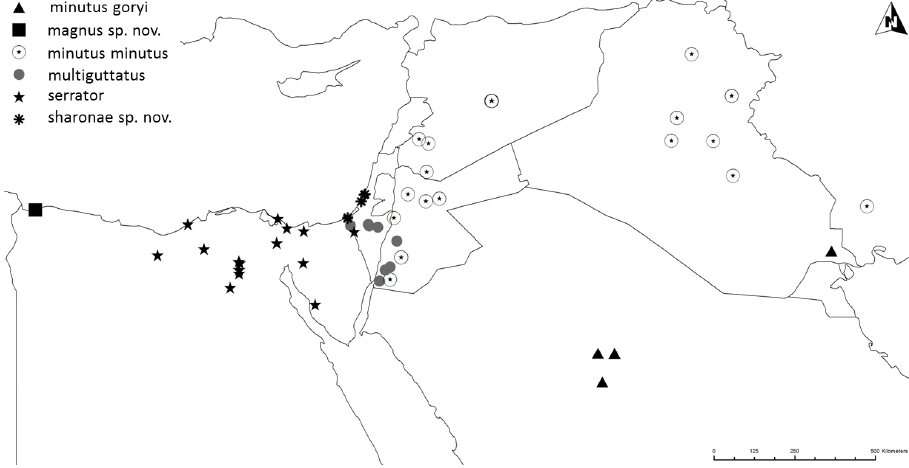
Figure 19. Distributional records of G. minutus minutus , G.minutus goryi , G. magnus sp. n., G. multigut- tatus , G. serrator, and G. sharonae sp. n.